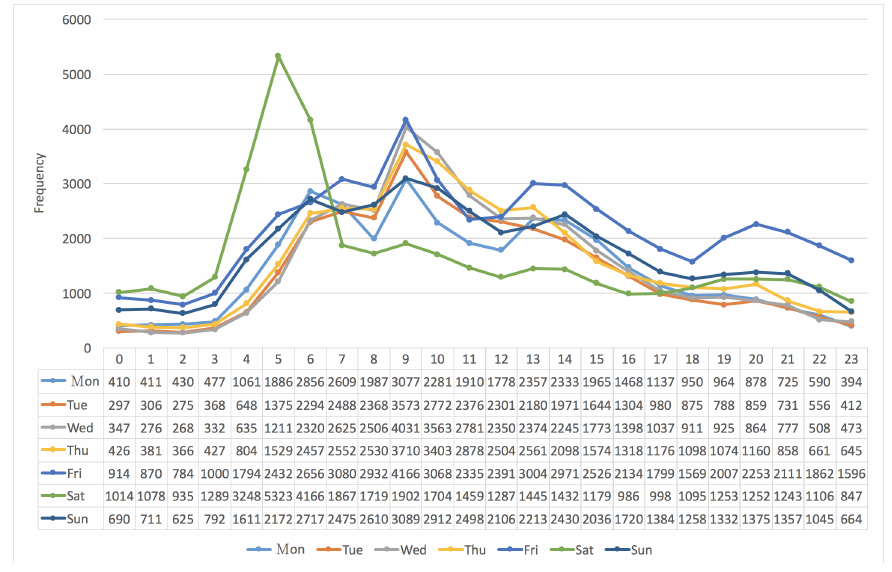
Figure 11. The frequency distribution of vehicles in the northern (N) direction vs. “24 h per day” and “seven days per week”.